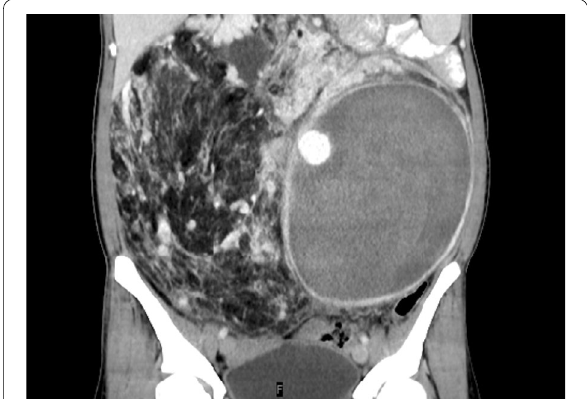
Fig. 5 Huge right-sided renal angiomyolipoma with a bleeding pseudoanurysm. Few hyperdense enhancing soft tissue densities were noted in the angiomyolipoma of the left kidney